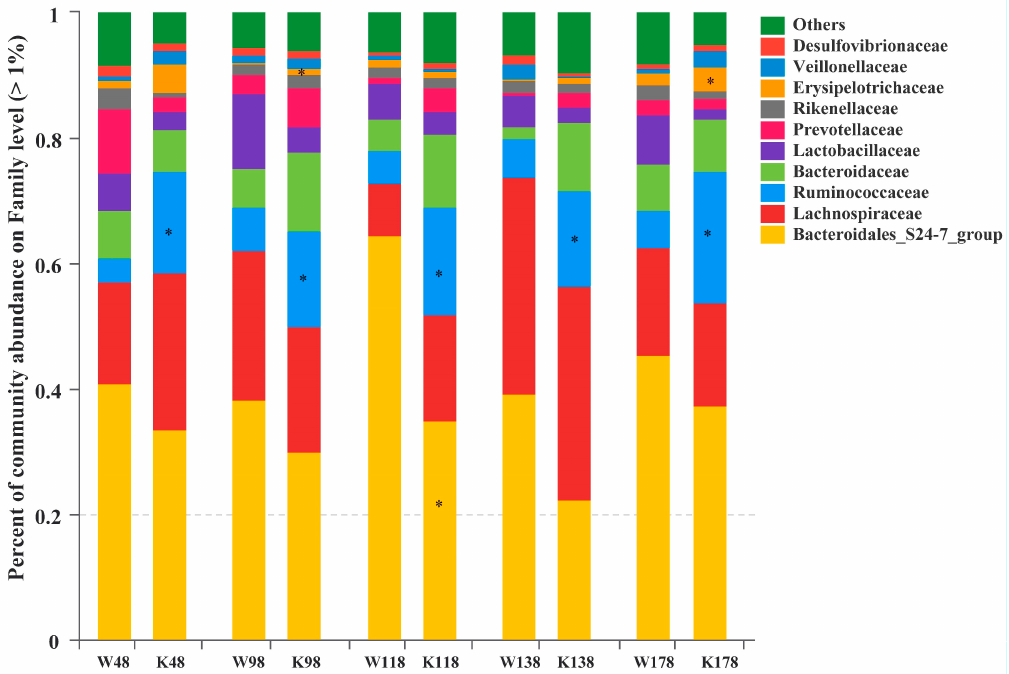
Figure 6. Relative abundance of the families exceeding 1% in Muc2 − / − and Muc2 +/+ mice at different time points. * indicated the significant differences ( p < 0.05) between Muc2 − / − and Muc2 +/+ mice. W, Muc2 +/+ mice; K, Muc2 − / − mice. The sample names at the x axis represented the sampling time and genotypes. For example, W48 indicated the samples collected from Muc2 +/+ mice at day 48, and K48 indicated the samples collected from Muc2 − / − mice at day 48.